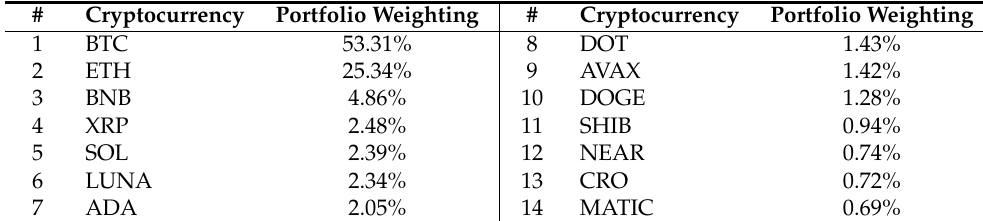
Table 7. Portfolio positions and